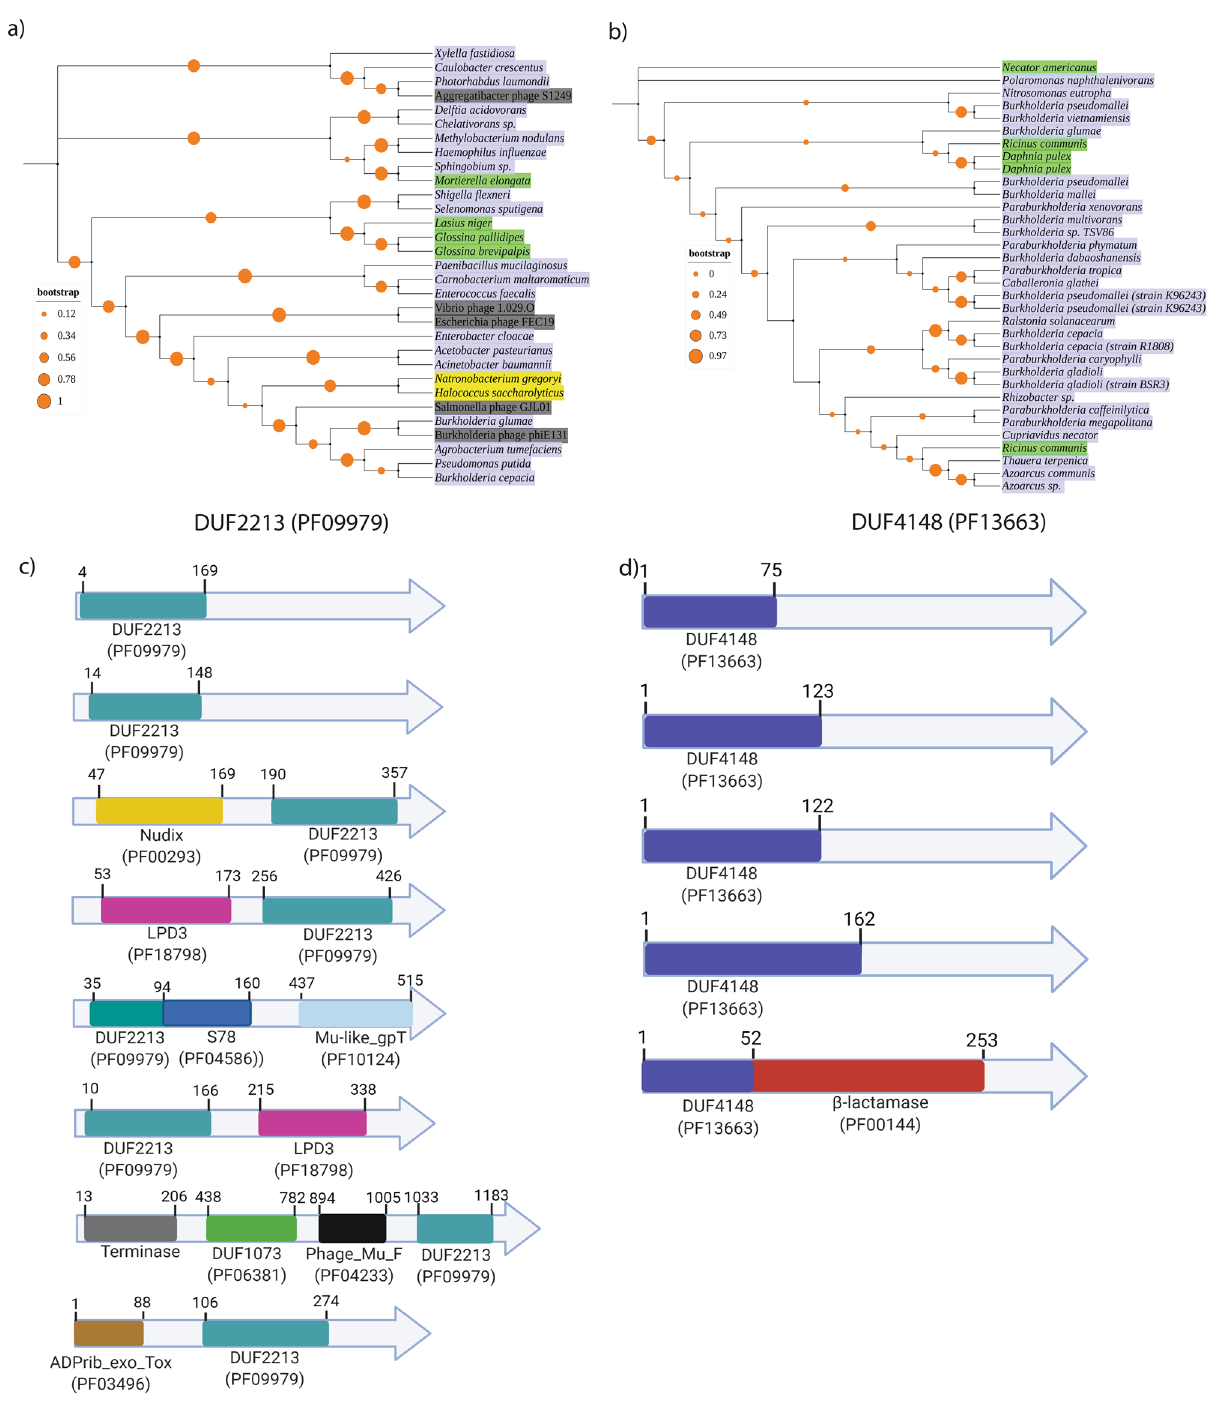
Figure 4. Phylogenetic trees with taxonomic information of DUF2213 (PF09979) and DUF4148 (PF13663) and domain architectures of proteins containing these domains. ( a – b ) Phylogenetic trees of DUF2213 ( a ) and DUF4148 ( b ) across the species with taxonomic annotations. DUF2213 is widely distributed within bacterial, archaeal, phage and eukaryotic species, whereas DUF4148 is mostly distributed in bacteria (primarily in Proteobacterial species). Trees shown here are the majority rule consensus trees. Taxonomic annotations were labelled based on NCBI taxonomy database. Representative bacterial, archaeal, phage and eukaryotic species are highlighted in lilac, yellow, grey and green, respectively. The orange circles on the branches represent the bootstraps values. ( c )–( d ) Domain architectures of proteins containing DUF2213 ( c ) and DUF4148 ( d ) across species. Numbers on top of the domains in ( c ) and ( d ) represent amino acid sequence